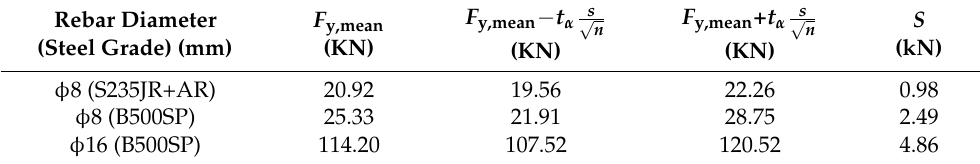
Table 2. The results from a statistical analysis for the forces F y yielding the test rebars. Rebar